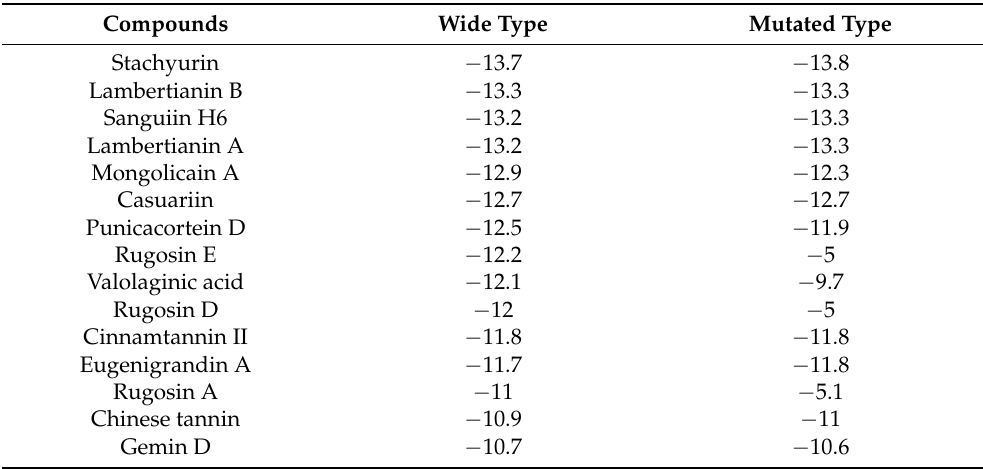
Figure 4E,F showed the root mean square deviation (RMSD) and root mean square fluctuation (RMSF) for GDF5 wild and mutated types binding to rugosin A. RMSD for GDF5 wild type binding with rugosin A was sustained close to 3 Å during 100 nanoseconds. RMSF for GDF5 wild-type binding with rugosin A also did not exceed 3 nm, except at the 580 residue index in the RMSF graph. These results suggest that rugosin A stably bound to the GDF5 wild type.